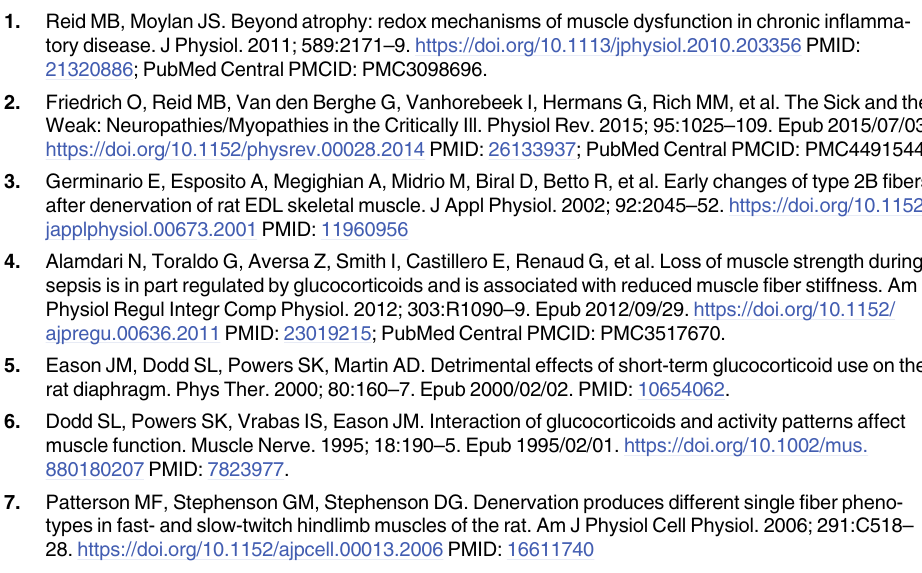
S1 Fig. Original uncropped blots used for Figs 3, 4, 5 and 7. Image was captured using a charge-coupled device camera attached to ChemiDOC MP (BioRad) and Image Lab Software was used for detection as well as densitometry. The part of the blot or gel shown in the manu- script is within the red